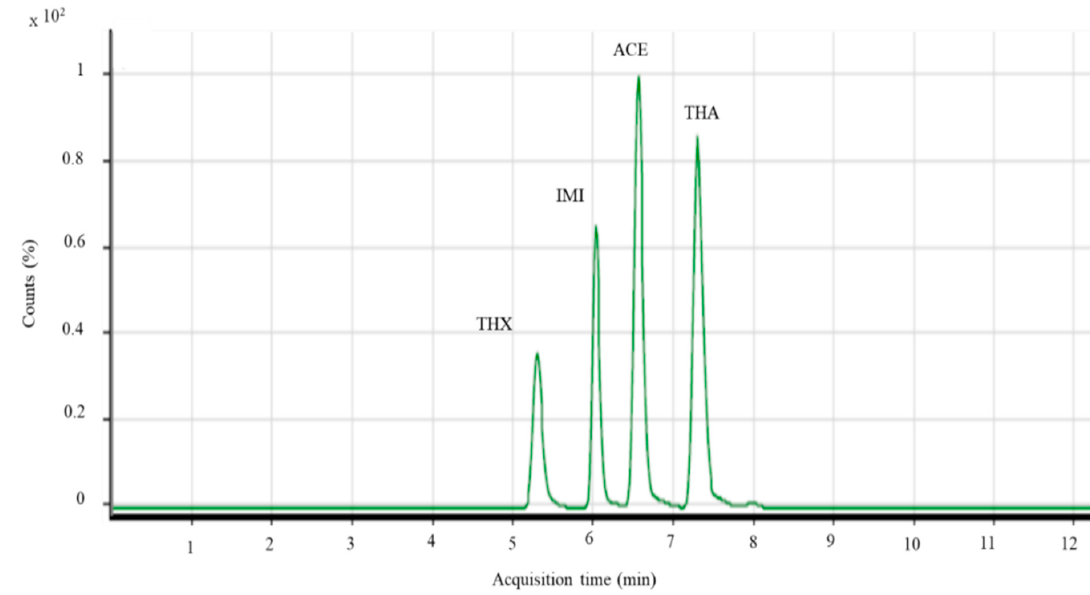
Figure 3. Total ion chromatogram of the four neonic compounds: Thiamethoxam (THX), Imidacloprid (IMI), Acetamiprid (ACE) and Thiacloprid (THA), obtained under optimised LC/MS/MS conditions.